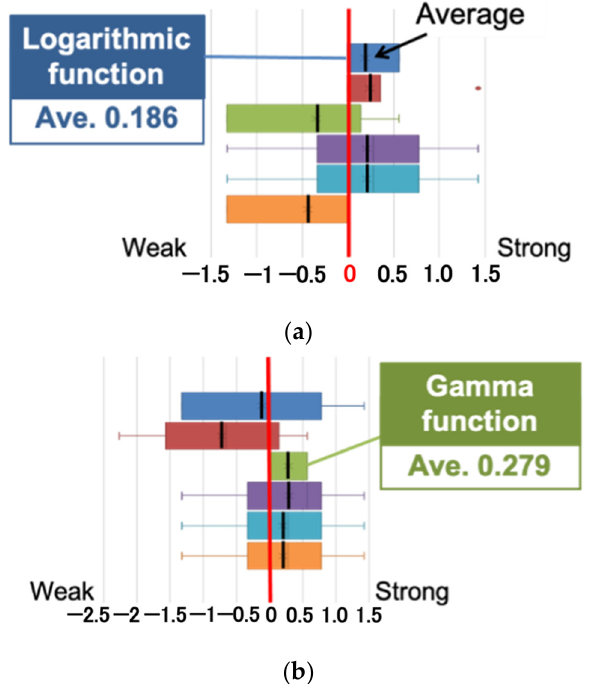
Figure 16. Results of the evaluation experiment. ( a ) Xperia1; ( b ) FireHD8.